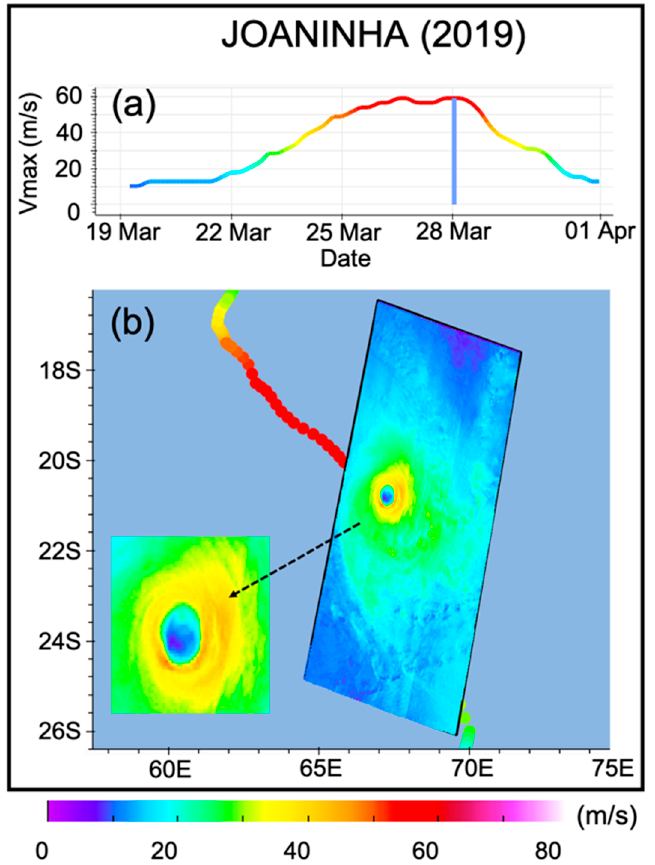
Figure 24. Intensity of TC JOANINHA (color scale at bottom). ( a ) Wind speed evolution with respect to time as given by ATCF and ( b ) SAR wind retrieval (RS2) on 28 March 2020 at 00:52 UTC.